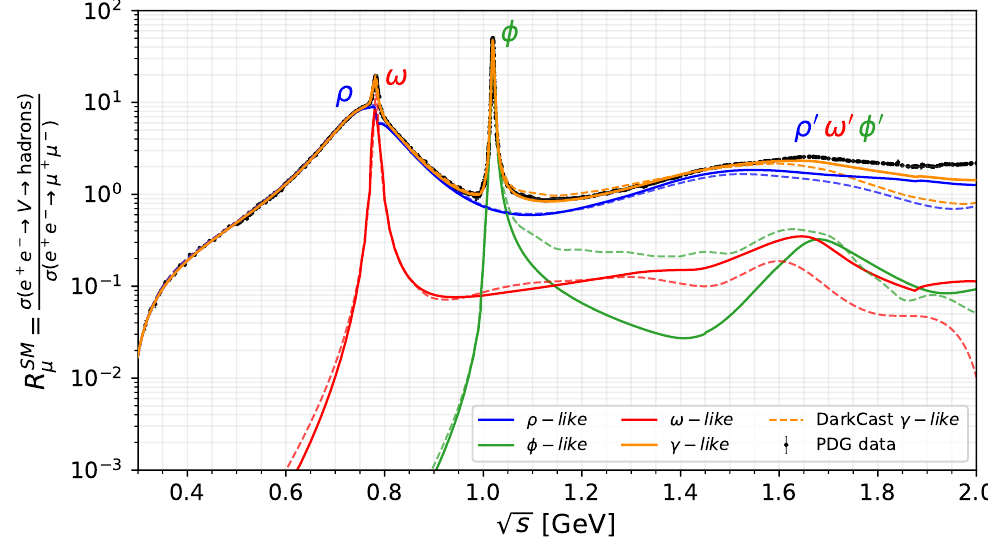
into ρ -, ω - and ≡ P R H µ µ H